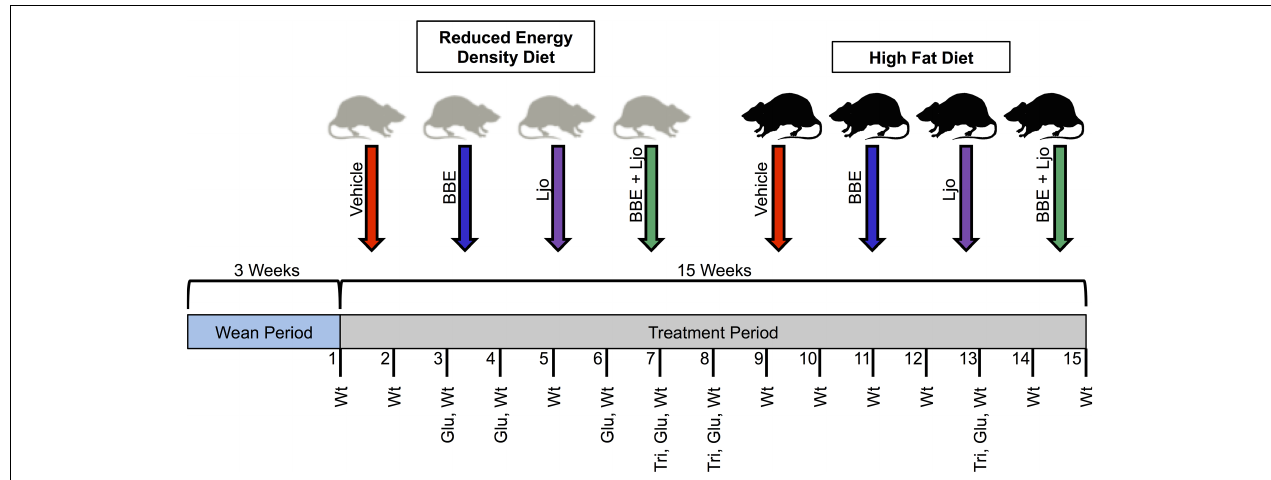
FIGURE 1 | Feeding assay design. Pregnant females gave birth, and pups were weaned after 3 weeks and separated into two diet groups (reduced energy density diet and high fat diet), each with four treatments (vehicle control, BBE = blueberry extract ; Ljo = L. johnsonii ; BBE + Ljo = blueberry extract + L. johnsonii ). Animals were treated three times a week for 15 weeks, during which regular monitoring of weight (wt), glucose levels (glu), and triglycerides levels (tri) were assessed.